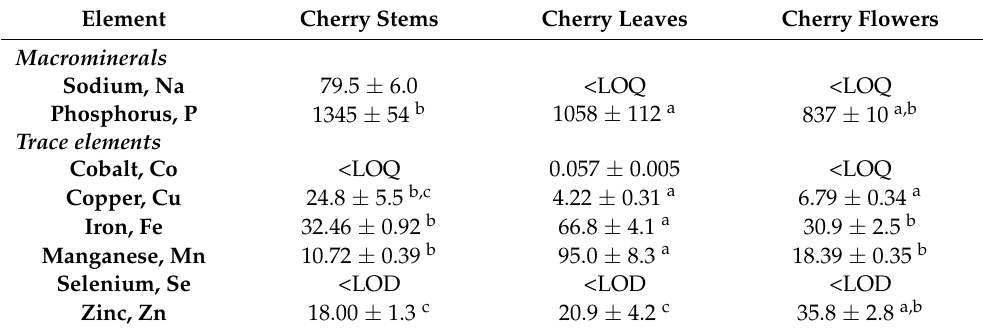
Table 1. Content of the eight essential elements (mg/kg of dw) found in the Prunus avium L. by- products from the Saco variety from the Fund ã o region (Portugal).